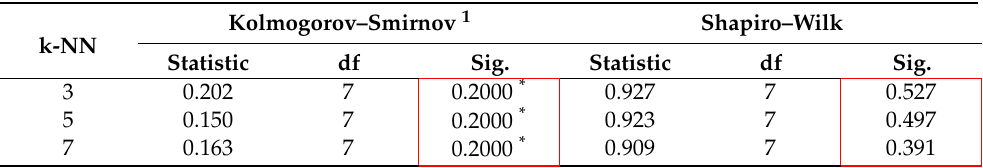
Table 4. Results of the normality test with the k value as 3, 5, and 7 (prediction success rate of grab gestures for each